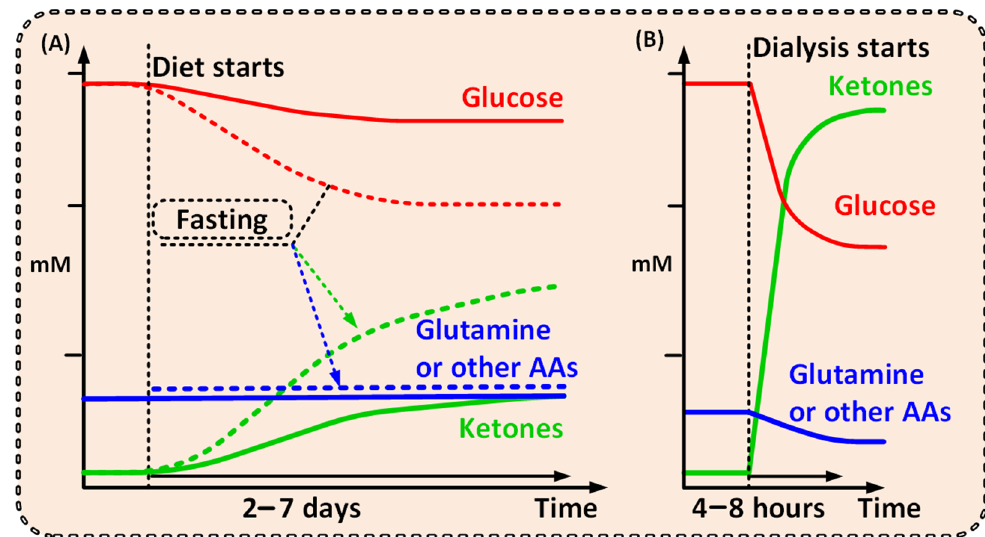
Figure 1. Graphs outlining the possible differences between the metabolite levels achieved over time from ( A ) a ketogenic diet [26,28] or fast [20,29], and from ( B ) dialysis. A comparably short dialysis treatment would shift the patient to a ketogenic metabolic condition, where high ketone and low glutamine levels will be unfavorable for cancer cells, but not healthy cells. A short dialysis treatment shifts the patient from one metabolic condition to another, unfavorable for the cancer but not for the patient as a whole.